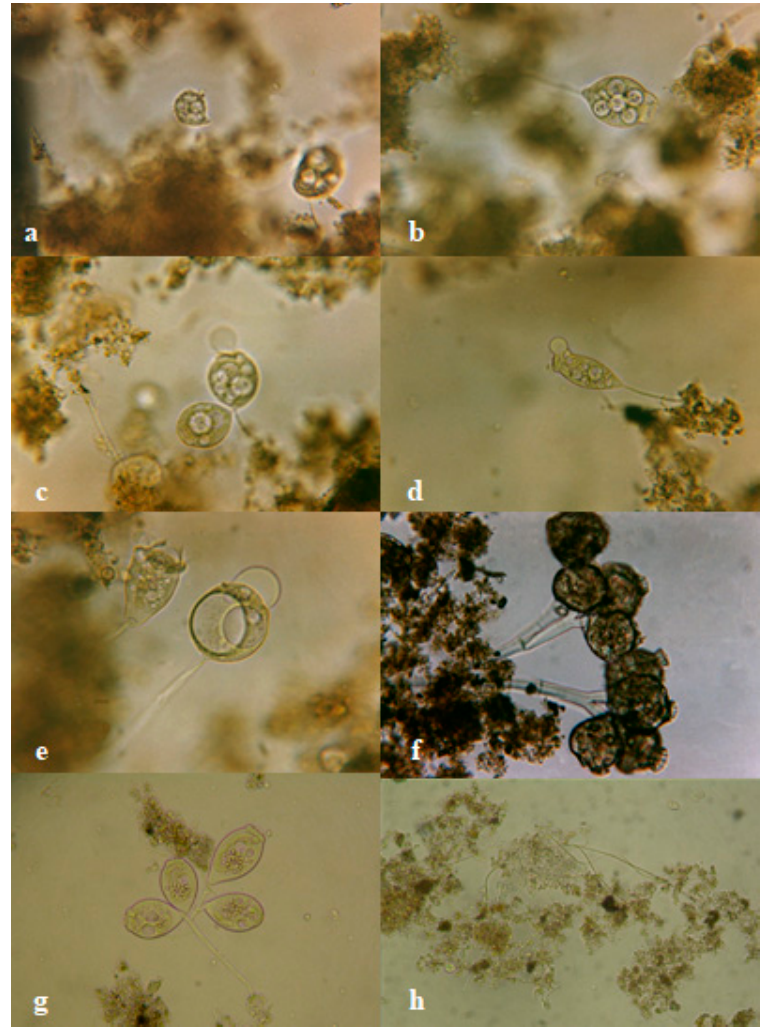
Figure 4. Aspidisca costata ( a ), Vorticella communis ( b ), Vorticella microstoma ( c ), Vorticella elongata ( d ), Vorticella convallaria ( e ), Epistylis spp. ( f ), Carchesium polypinum ( g ) damaged due to sewage from the production of acrylonitrile rubbers and activated sludge flocs ( h ) with visible perforations and holes (photo by Iwona B. Pa ś mionka).